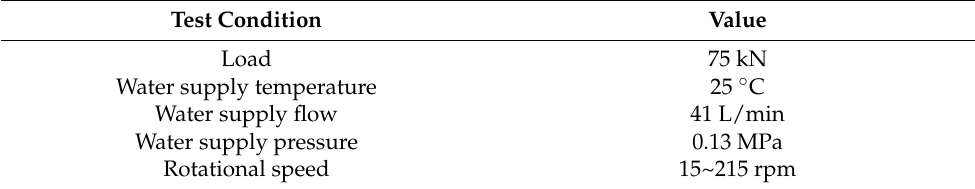
Table 3. Test-condition